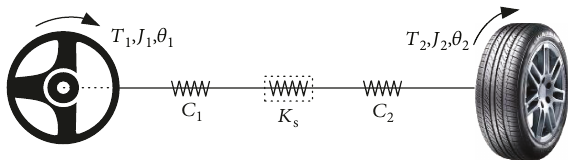
Figure 4: Equivalent model of the steering